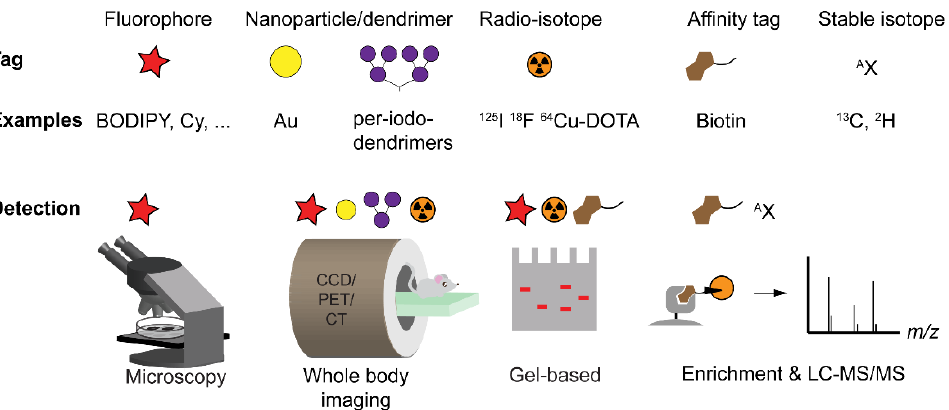
Figure 2. Detection strategies in ABPP. Overview of di ff erent types of tags with examples and techniques for detection. CCD: charge-coupled device camera (optical), PET: positron emission tomography, CT: X-ray computed tomography, LC-MS / MS: liquid chromatography with tandem mass spectrometry. Note that fluorescence detection in whole body imaging can only detect signal generated several millimeters under the skin due to the limited tissue penetration of light.